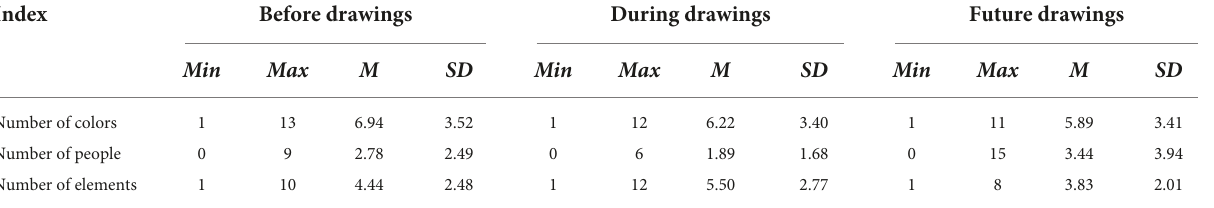
TABLE 3 Descriptive statistics on quantitative drawing indices.